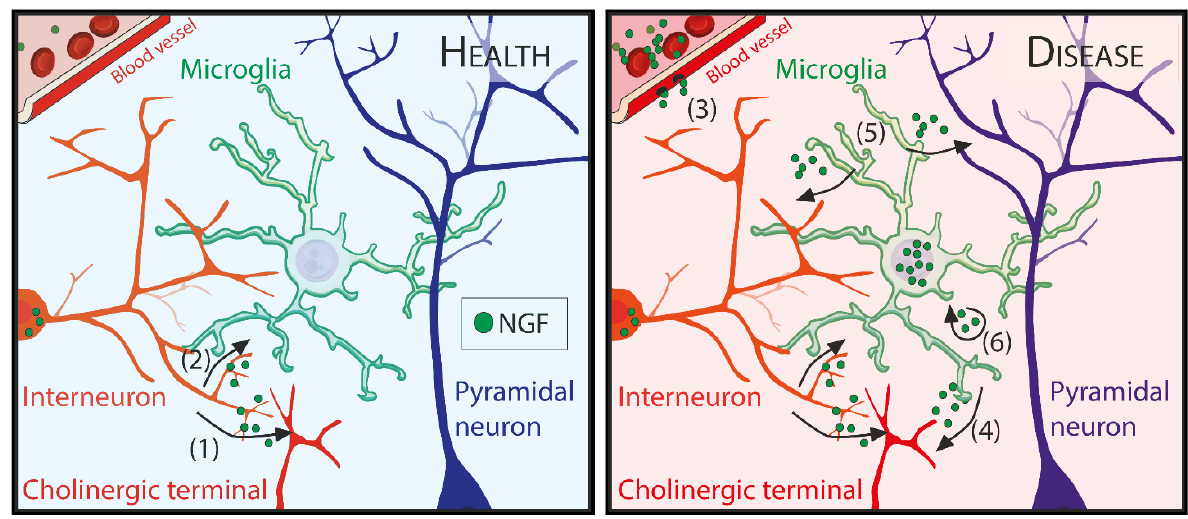
Figure 1. Hypotheses on the activity of NGF on microglia in vivo . In health (left panel), (1) NGF is produced by interneurons and should act as a tonic modulator of cholinergic activity. Microglia, which have access to the synaptic cleft, (2) could possibly sense a spillover of neurotrophin and participate in the homeostatic changes brought about by the increase in arousal upon NGF effect on acetylcholine production, affecting neuronal activity. In disease (right panel), concentrations of NGF increase systemically under inflammatory conditions and (3) might reach the brain parenchyma if the BBB is disrupted. Moreover, NGF/proNGF can also be produced by activated microglia to act on (4) TrkA receptors that are exclusively expressed on cholinergic neurons or, (5) as proNGF, on p75 NTR expressed by other neuronal populations. Microglia could themselves be affected (6) by the increase in NGF as suggested by Rizzi et al. 2018 [105] with a paracrine or autocrine loop that could possibly help keeping the inflammation in check avoiding the neurotoxic side effects of